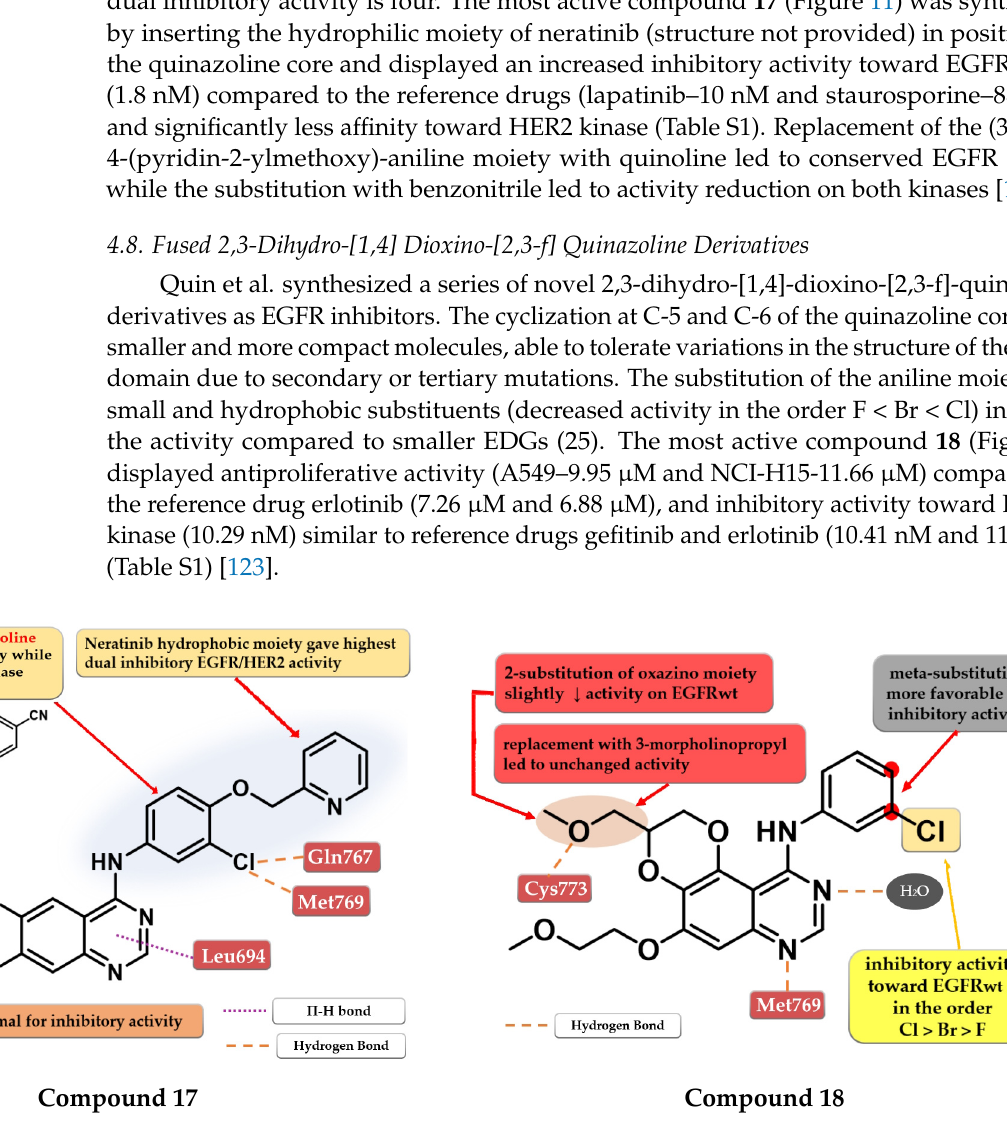
Figure 11. Structure–activity relationship and molecular docking of compound 17 in the human EGFR kinase domain (PDB ID 1M17) [124], as reported by Elkamhawy et al. [122]; structure–activity relationship and molecular docking of compound 18 in the human EGFR kinase domain (PDB ID 1M17) [124], as reported by Quin et al. [123].